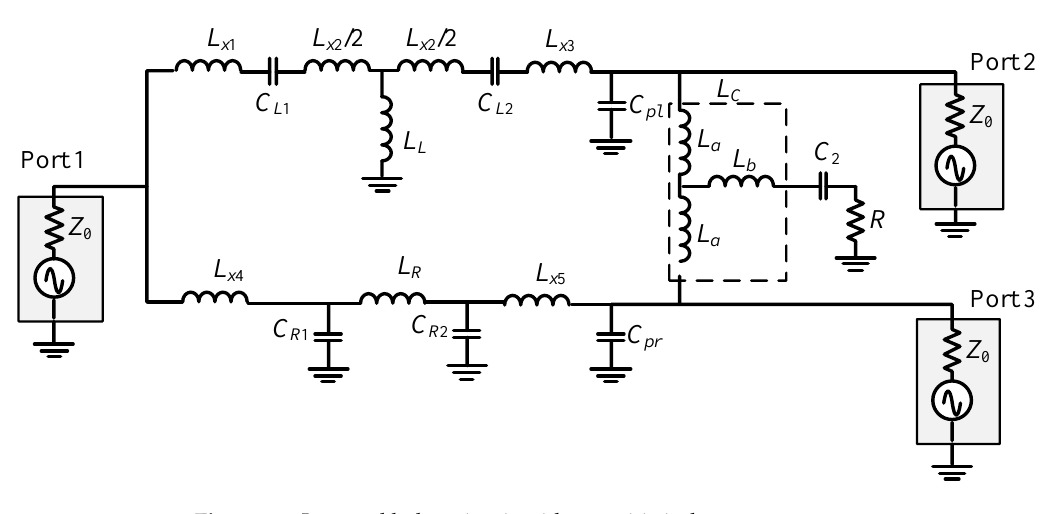
Figure 10. Balun circuit photo.